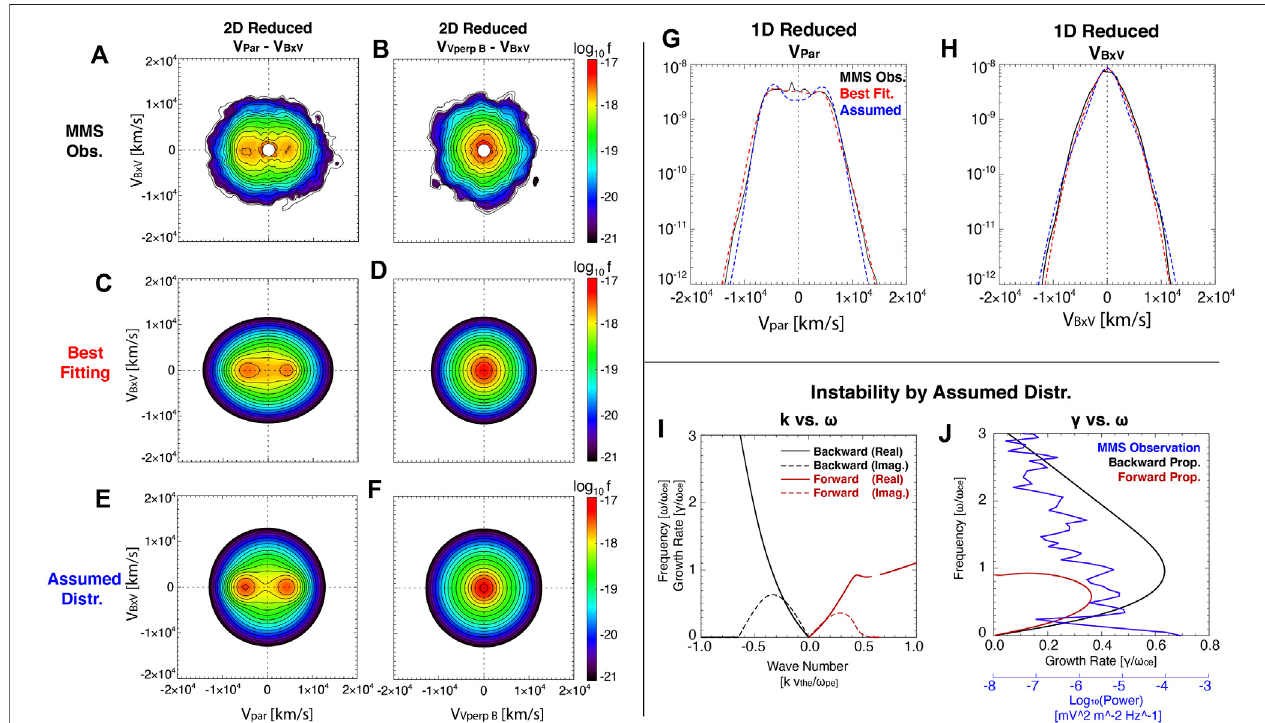
FIGURE 3 | (Left) 2D reduced electron distribution of (A, B) MMS observation, (C, D) the best fi tting, and (E, F) an assumed distribution for wave instability in V par -V B × V and V V -V B × V space. (Right Top) 1D reduced distribution in (G) V par , and (H) V B × V space: (black) MMS observation, (red) the best fi tting, and (blue) the perp × B assumed distribution. (Right Bottom) Instability derived from the assumed distribution. (I) wave number k vs. frequency ω . (black) the backward-propagating mode, and (red) the forward-propagating mode. Solid lines and dashed lines are real and imaginary parts of solutions. (J) Comparison between (red) the forward-, (black) backward-propagating mode, and (blue) power spectrum in MMS